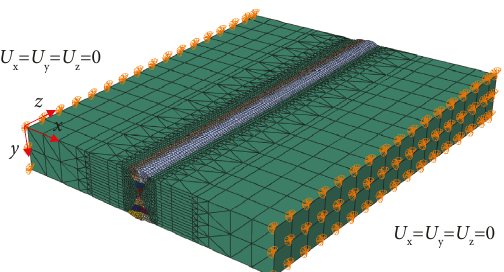
Figure 14: Schematic diagram of the second constraint condition.